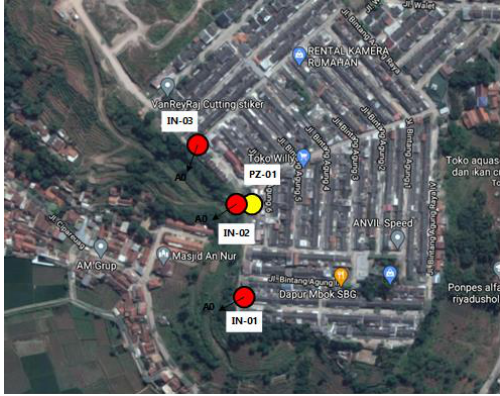
Figure 12. Location of the inclinometer in Cimanggung slope failure.